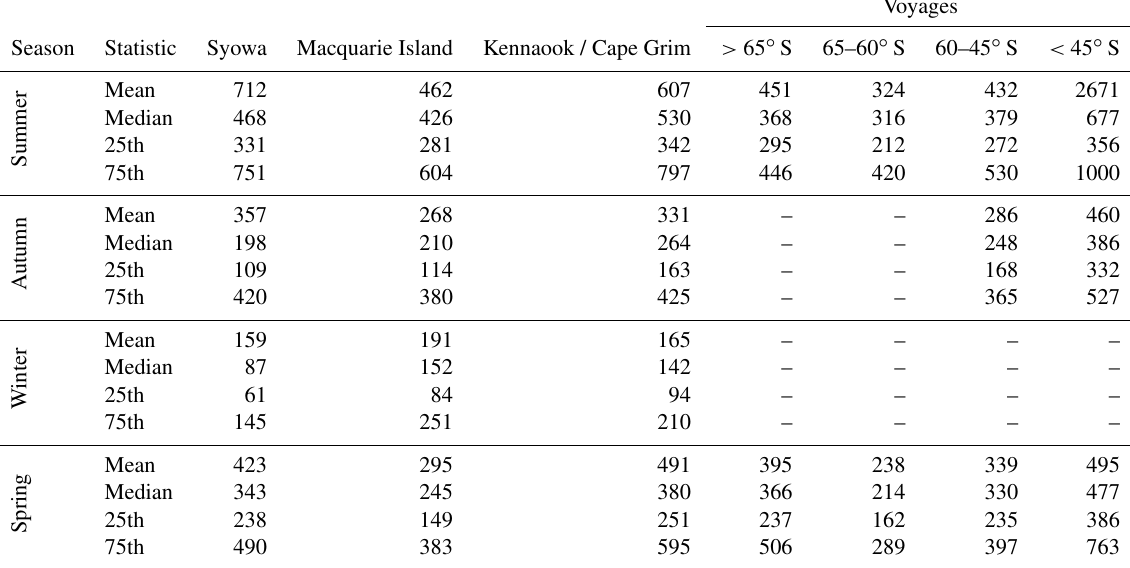
Table A1. Seasonal summary statistics from stations and voyages for CN 10 .